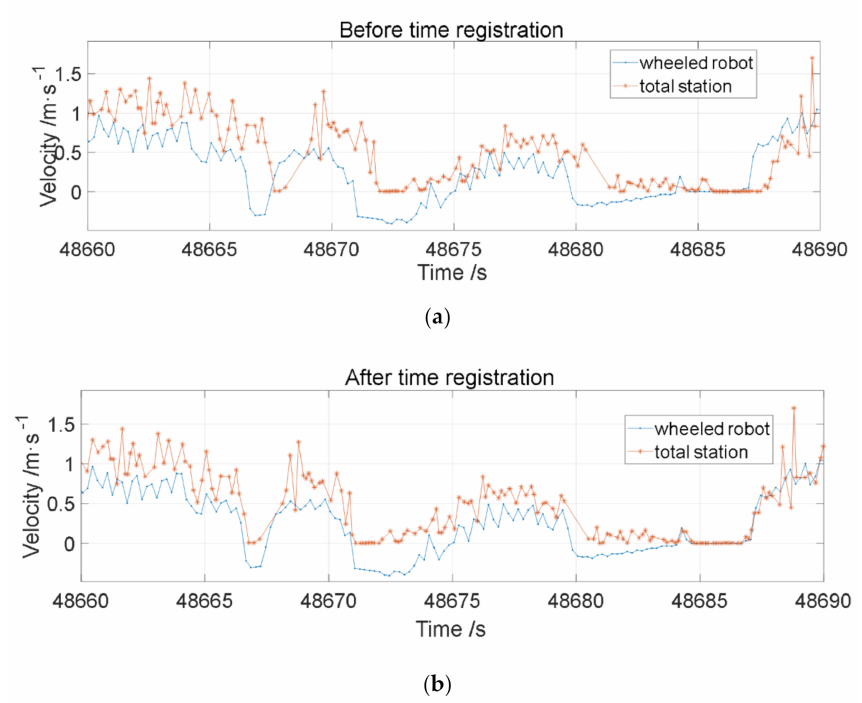
Figure 5. Time synchronization between the total station and INS. ( a ) Time-velocity plot before time registration; ( b ) time-velocity plot after time